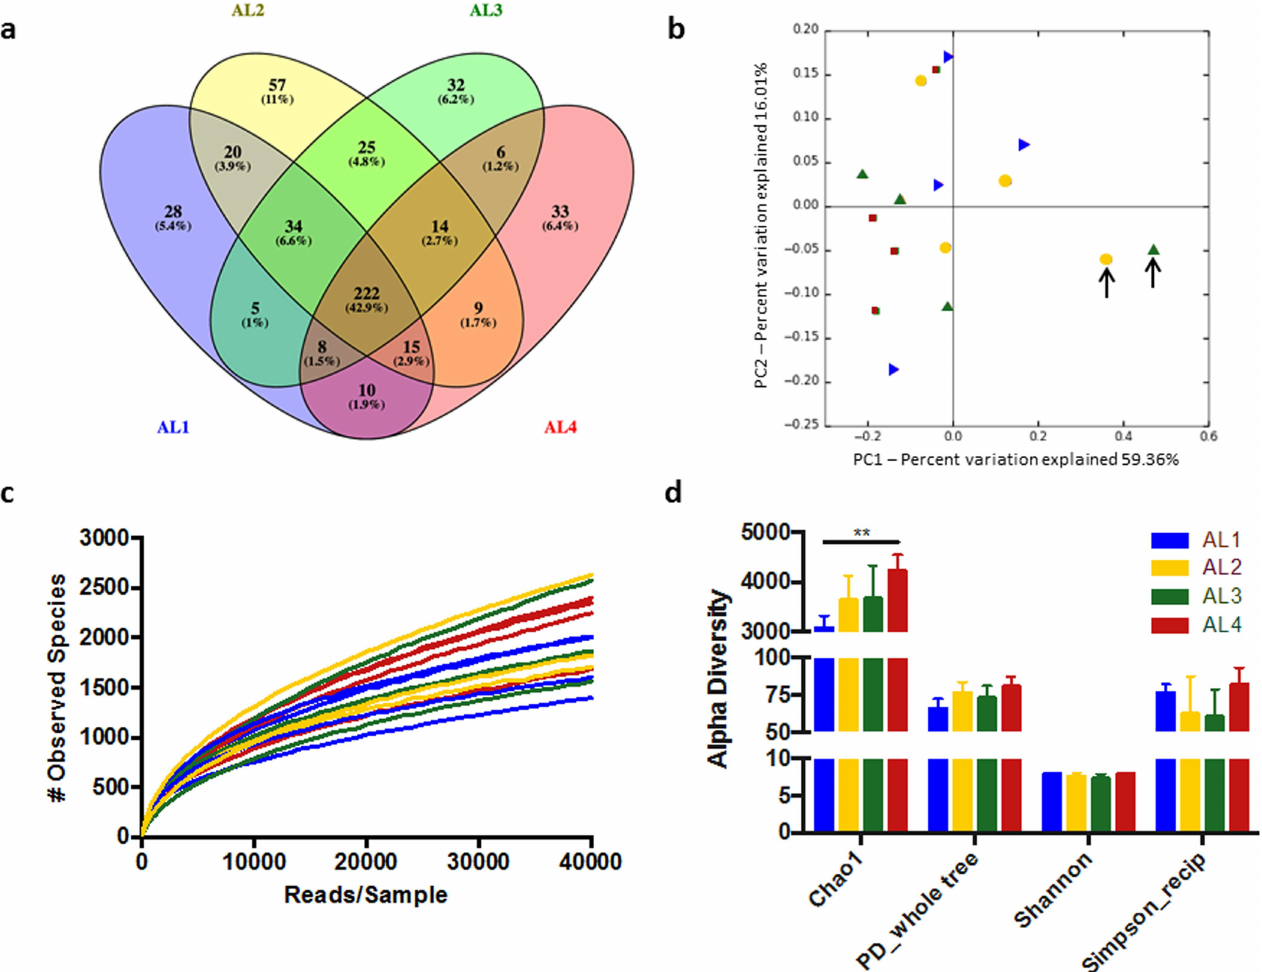
Fig 3. Species overlap, composition, and alpha diversity by anatomic location (a) Venn diagramshowingthe overlap of the 518 identified species between anatomic locations (n = 4/AL). (b) Weighted PCoA Plots wherein each point (n = 16) represents a single swab, reveals the swabs containingabnormallyhigh Actinobacteria, indicatedby the arrows. PERMANOVA analysis revealed no significant groupingbetween anatomic locations(p > 0.05). (c) Rarefaction curves for each swab from zero to 40,000 reads per sample showingthe number of observed species at each read depth. (d) Chao1 (richness, p = 0.0054), PD_wholetree (diversity, n.s.), Shannon(diversity, n.s.), Simpson (Evenness, n.s.) indices of alpha diversity. AL1 (blue), AL2 (yellow), AL3 (green), AL4 (red). ** p < 0.01(2-way ANOVA with Tukey’s Post-testing n = 4/AL).